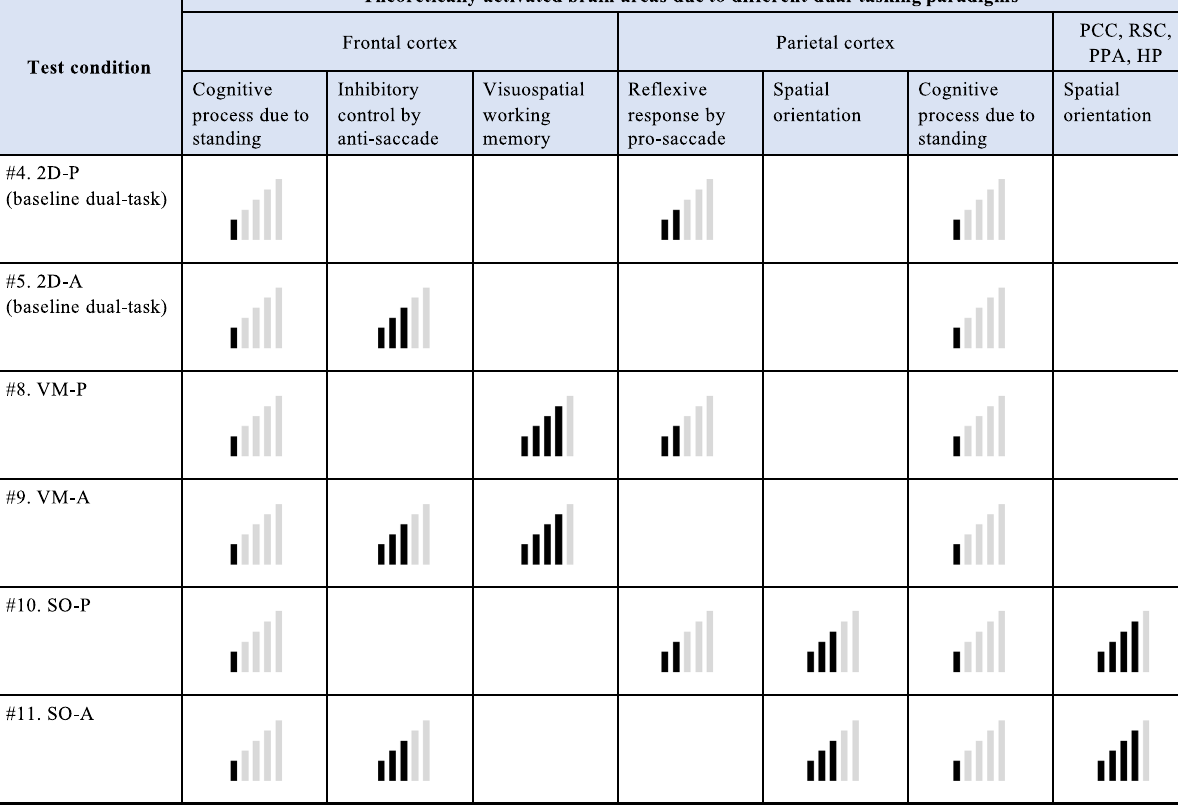
Figure 5. Dual-tasking assessment approaches formulated based on the findings of this study (symbols of signals illustrate which regions of the brain are activated theoretically in each test). Baseline assessment: conditions in 2D VR environment require basic dual-task of posture maintenance and saccadic eye movements: Test #4: Baseline condition with pro-saccade (2D-P) could be a simple comprehensive assessment to test the functions of frontal lobe and parietal cortex overall; Test #5: Baseline condition with anti-saccade (2D-A) could be a simple intensive test for the frontal lobe. Comprehensive assessment with an intensity in either the frontal lobe or the parietal cortex: Test #8: Pro-saccade test with visuospatial memory task (VM-P) would evaluate the frontal lobe and parietal cortex comprehensively, while requiring more intensity in the frontal lobe. Saccade latency and pupillary response could signify the function of visuospatial memory; Test #11: Anti-saccade test with spatial orientation task (SO-A) would also investigate the frontal lobe, parietal cortex, posterior cingulate cortex (PCC), retrosplenial cortex (RSC), parahippocampal place area (PPA), and hippocampus (HP) more comprehensively, while relatively requiring an intensity in the parietal cortex. Saccade latency could signify the function of spatial orientation. Highly intensive assessment in either the frontal lobe or the parietal cortex: Test #9: Anti-saccade test with visuospatial memory task (VM-A) could activate the frontal lobe more intensively, possibly reaching a maximum resource capacity to affect postural sway. Postural sway could indicate the possible overload in the frontal lobe; Test #10: Pro-saccade test with spatial orientation task (SO-P) would also intensify activities in the parietal cortex, possibly reaching a maximum resource capacity to affect postural sway. Postural sway could imply the maximum resource capacity in the parietal